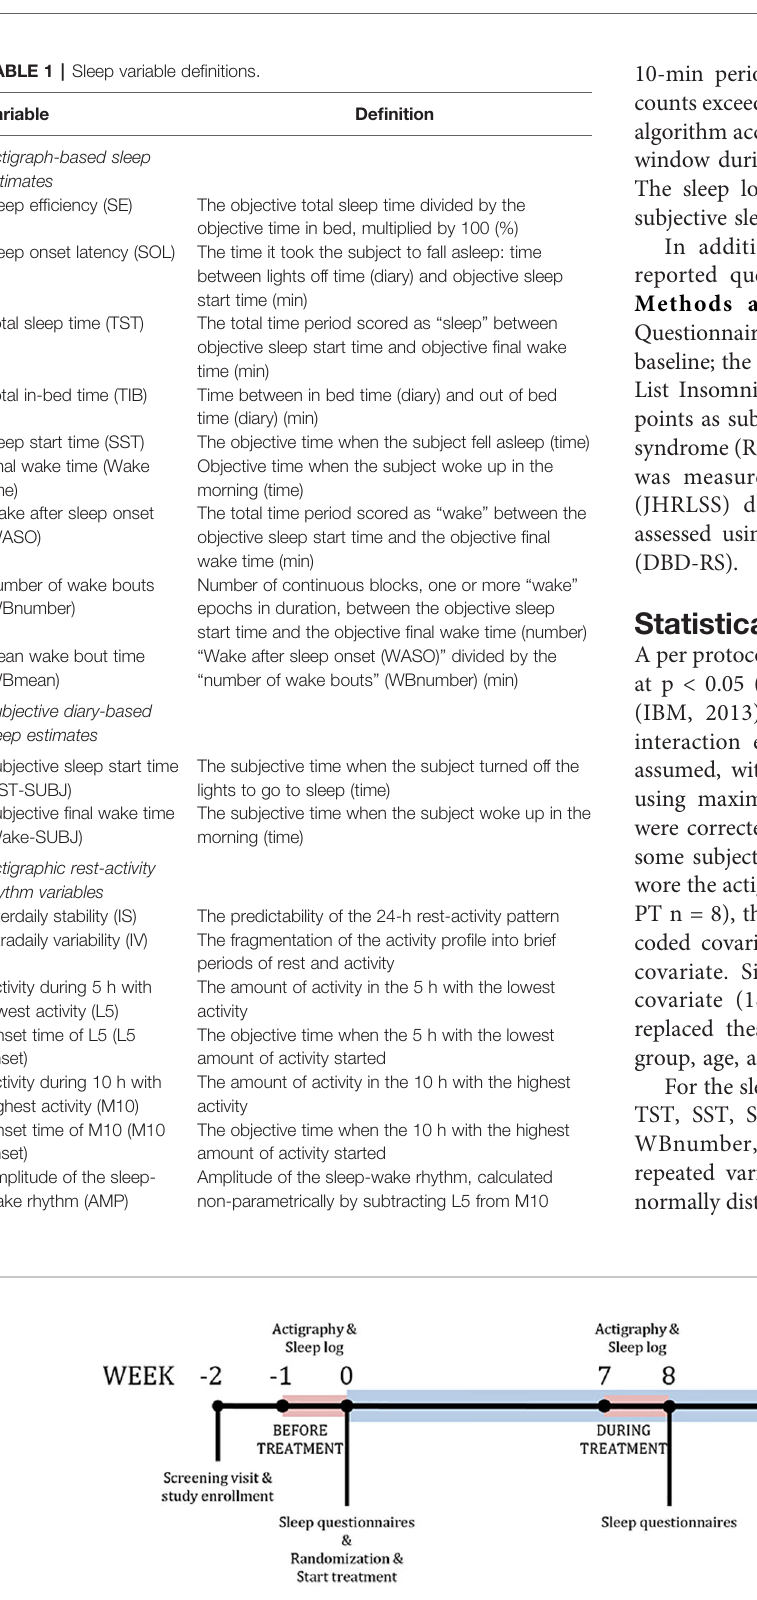
FIGURE 1 | Study design. Timeline of the study. Blue bar represents treatment period. Red bars represent sleep measurement periods using the actigraph.